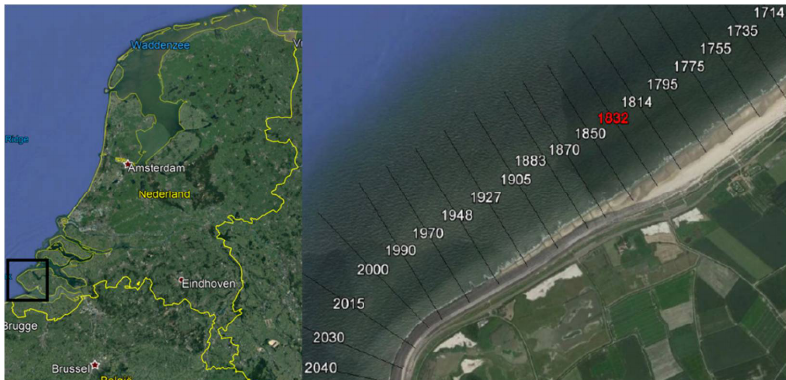
Figure 1. The Netherlands, with the coast of Walcheren indicated ( left ). The Westkapelle sea defence, with the bathymetrical transects indicated ( right ). Transect 1832 is shown in red.